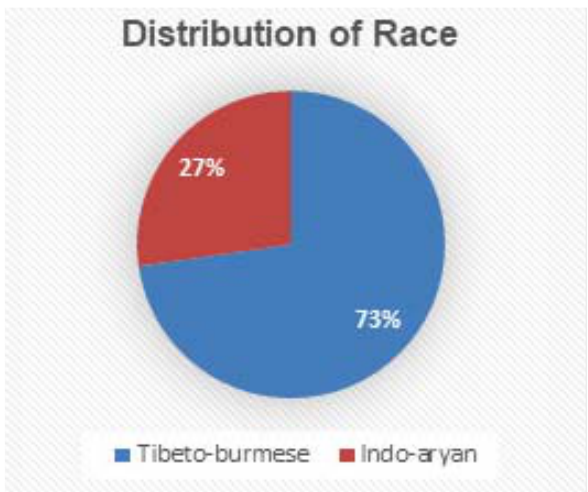
Figure 2. Distribution of Race